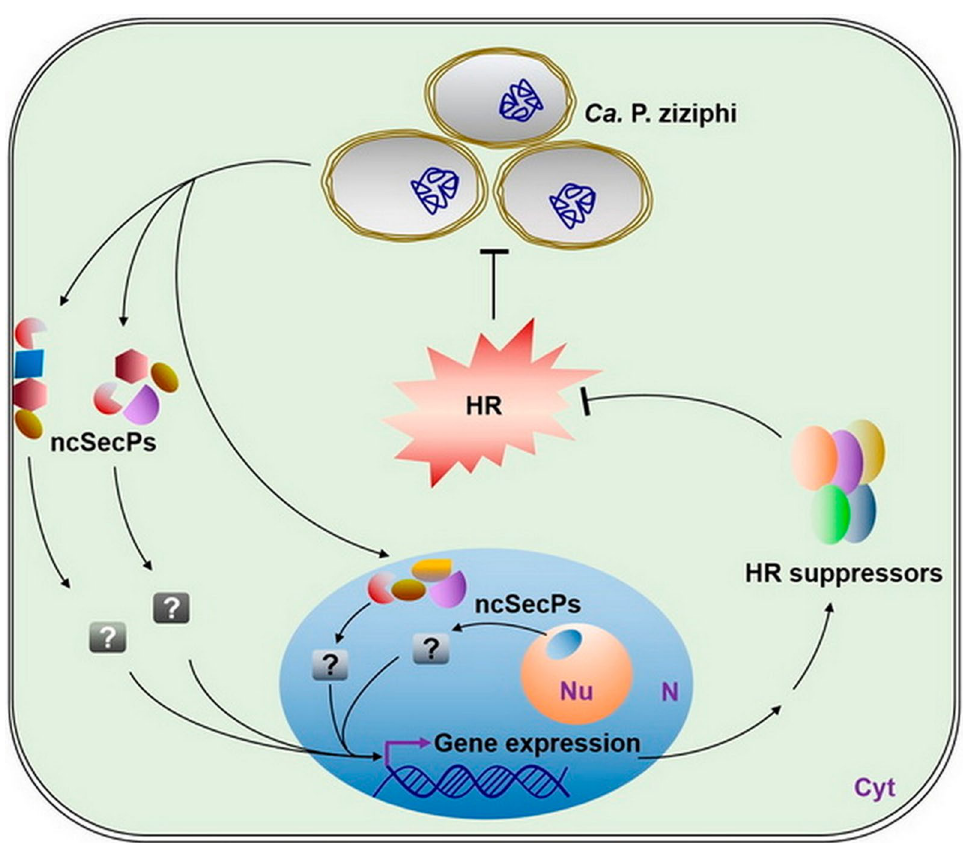
Fig. 6 The proposed model for the Candidatus Phytoplasma ziziphi bacterium deploying their ncSecPs to circumvent the host plant HR. As an intracellular bacterium, Ca. P. ziziphi secretes at least six ncSecPs that may target different plant subcellular compartments but work together to upregulate the gene expression of specific HR inhibitors, including pathogenesis-related proteins (PR-1, PR-2, and PR-5) and Bax inhibitor-1 (BI-1), via unknown mechanisms. The overexpressed HR inhibitors subsequently cause HR suppression, which favors colonization and infection of Ca . P. ziziphi. Blunt arrows indicate the negative impacts. ‘Cyt’ represents cytoplasm, while ‘N’ and ‘Nu’ indicate nucleus and nucleolus,